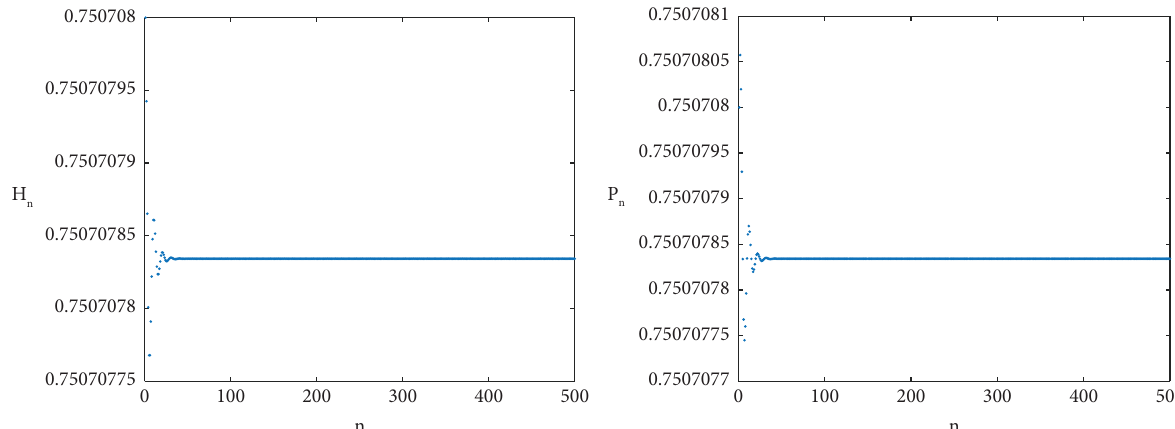
Figure 3: When R � 2 ,k � 1 , c � 0 . 8 ,R ln ( R ) + 1 − R / R ln ( R ) � 0 . 278652 , σ � 0 . 5, system (37) is asymptotically stable at the positive equilibrium point ( H ∗ ,P ∗ ) � ( 0 . 750708 , 0 . 750708 ) . Parasite and host populations are maintained in a relatively stable state.